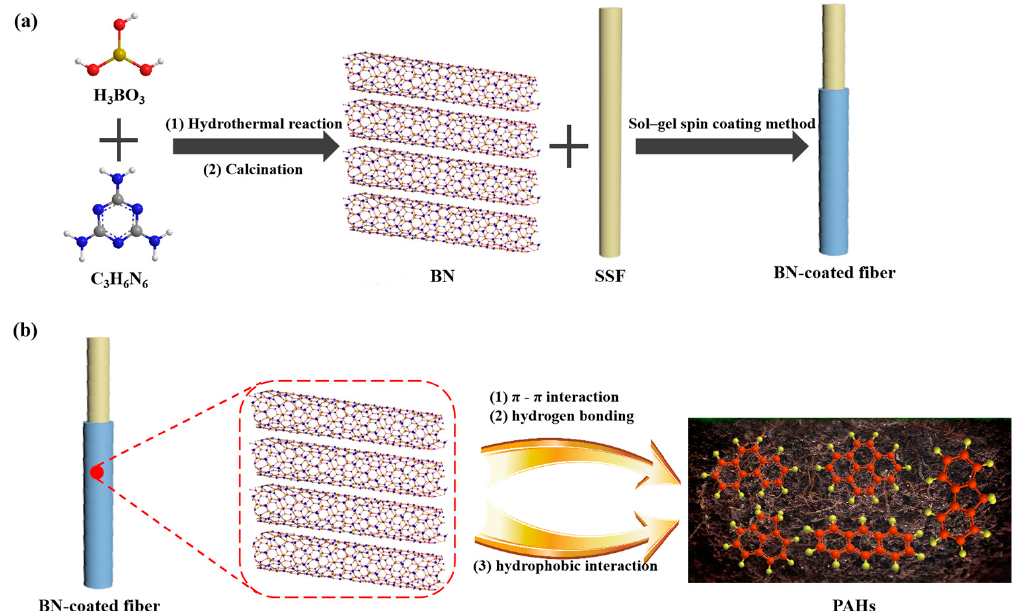
Figure 1. Schematic illustration of the fabrication of h-BN-coated SPME fiber ( a ) and its extraction process ( b ).